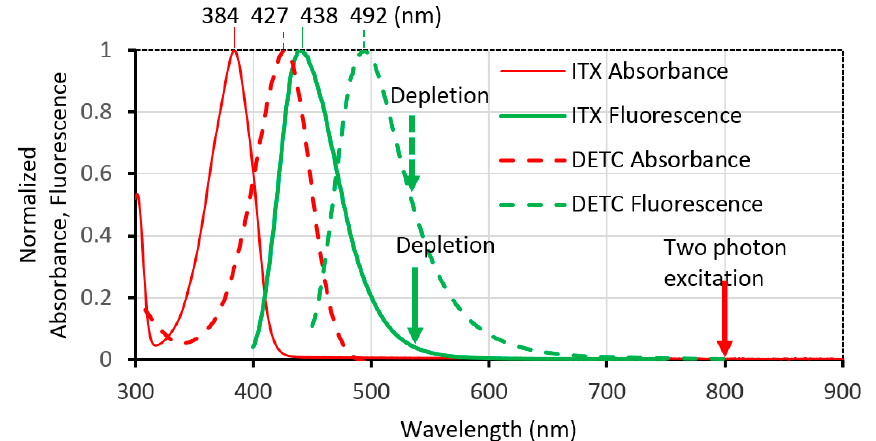
Figure 2. Absorbance and fluorescence spectra of two photoinitiators, solid line: 0.5 wt% isopropyl thioxanthone (ITX) in pentaerythritol triacrylate (PETA), dashed line: 0.5 wt% 7-diethylamino-3-thenoylcoumarin (DETC) in PETA. STED direct laser writing experiment was conducted to